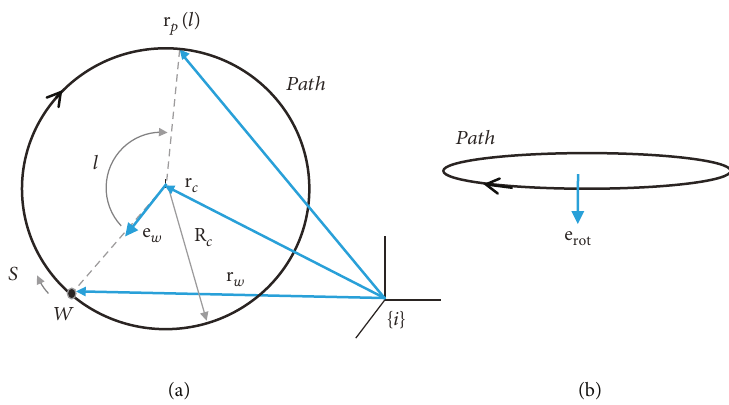
Figure 7: Parametric representation of a circular path ((a) top view, (b) side view).